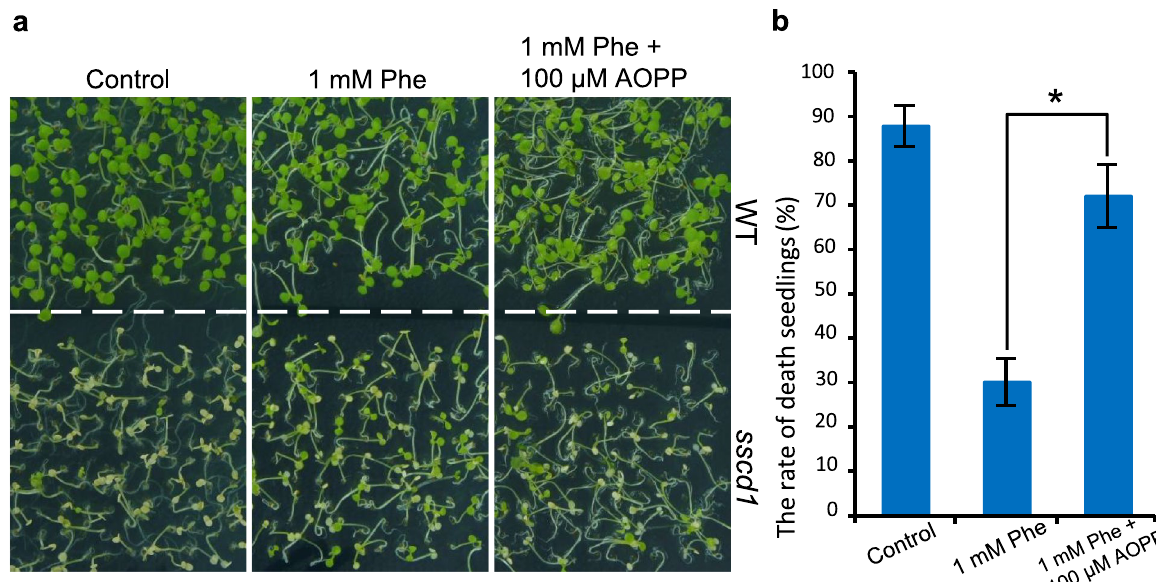
Figure 4. Treatment with AOPP reduced the inhibitory effect of Phe on the sscd1 seedlings death. ( a ) The phenotype of 7-d-old wild-type WT and sscd1 seedlings which were first grown in the medium added without (control) or with 1 mM Phe under SD for 2 days and then the seedlings in 1 mM Phe were treated with ddH 2 O (1 mM Phe) or 100 μM AOPP (1 mM Phe + 100 μM AOPP) for an additional 5-d growth. ( b ) The death rate of 7-d-old sscd1 seedlings which were first grown in medium added without (control) or with 1 mM Phe under SD for 2 days and then the seedlings in 1 mM Phe were treated with ddH 2 O (1 mM Phe) or 100 μM AOPP (1 mM Phe + 100 μM AOPP) for an additional 5-d growth. Error bars represent standard deviations (n > 30). The experiment was performed in three independent biological repeats. An asterisk represents the significance of differences (two-tailed Student’s t-test) at the levels of p < 0.05. WT wild type, Col-0; Phe phenylalanine; SD short